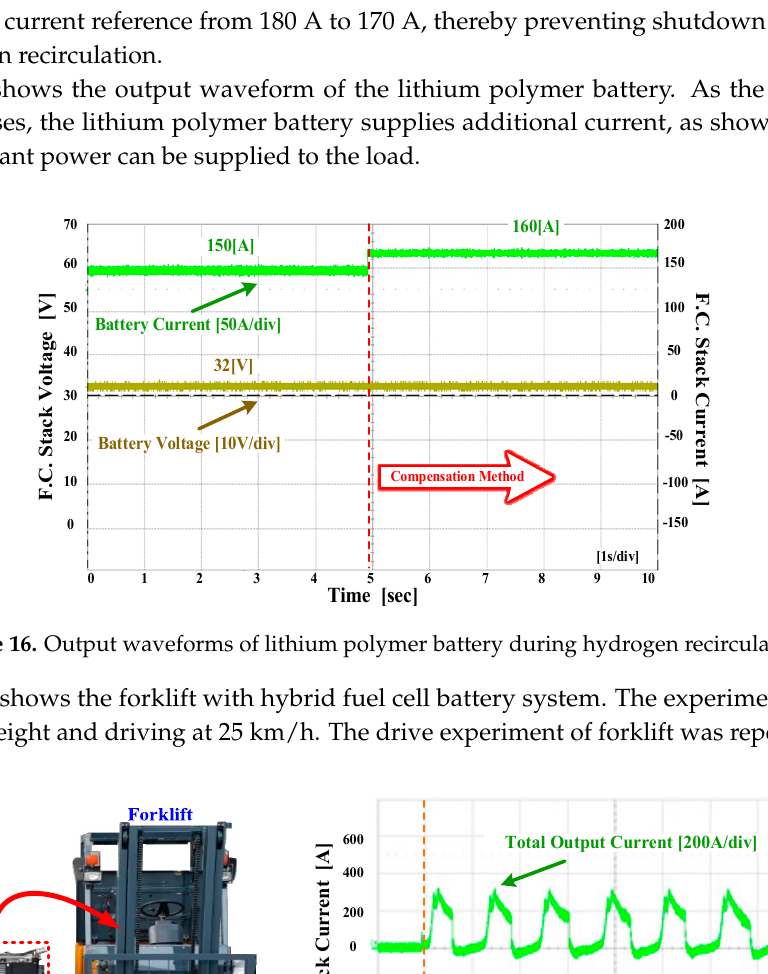
Figure 15. Output waveforms during hydrogen recirculation ( a ) not applied compensation method and ( b ) applied proposed compensation method.